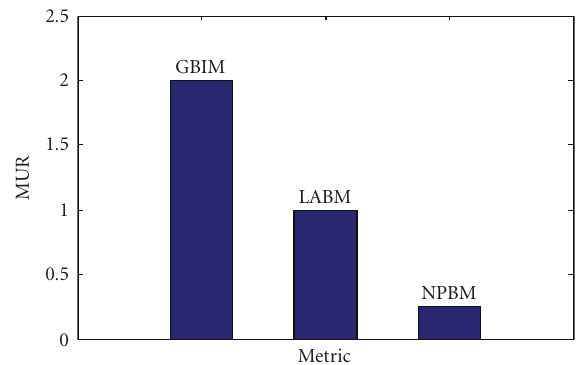
Figure 12: Comparison of the computational cost of three metrics, using model utilization ratio